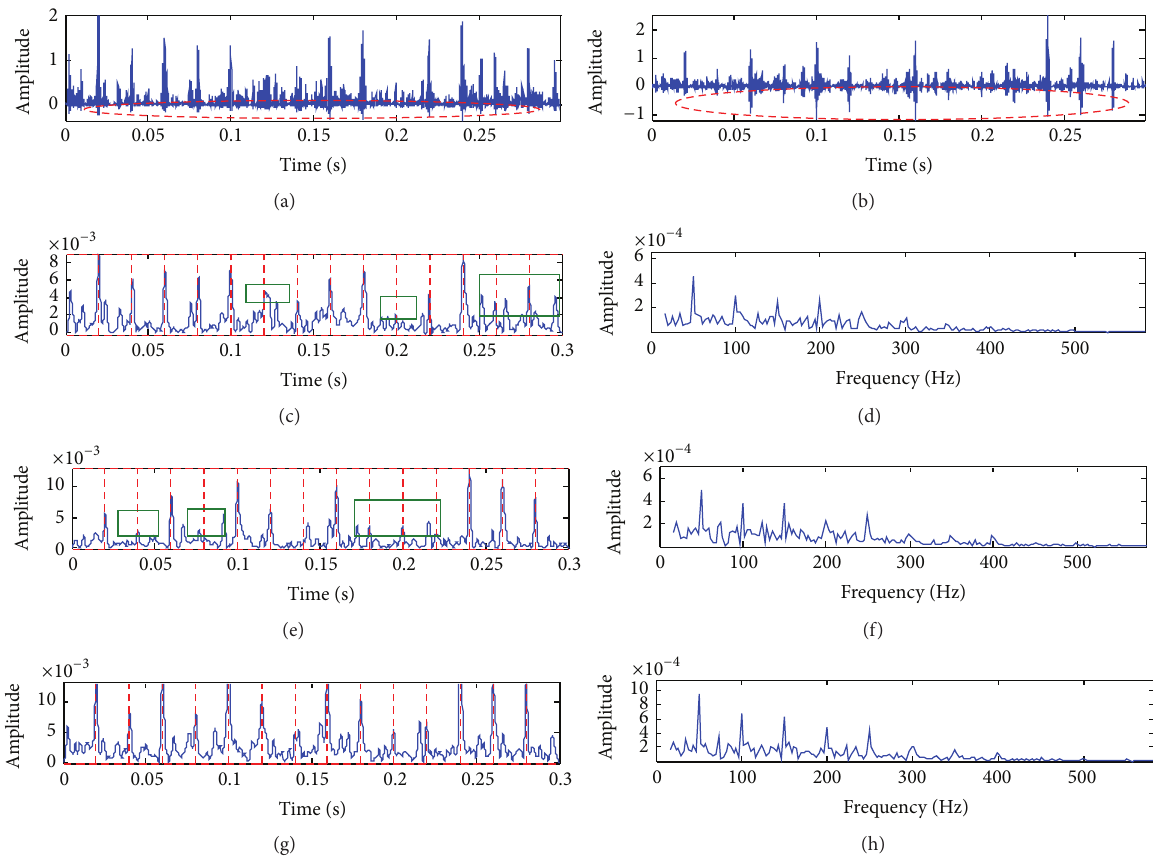
Figure 11: Enhanced waveform and its power spectrum by the proposed method: (a) enhanced waveform of the second mode by TEO; (b) enhanced waveform of the third mode by TEO; (c) enhanced waveform of the second mode by MTEO; (d) power spectrum of the second mode enhanced waveform by MTEO; (e) enhanced waveform of the third mode by MTEO; (f) power spectrum of the third mode enhanced waveform by MTEO; (g) enhanced waveform of the combined mode; (h) power spectrum of the combined mode enhanced